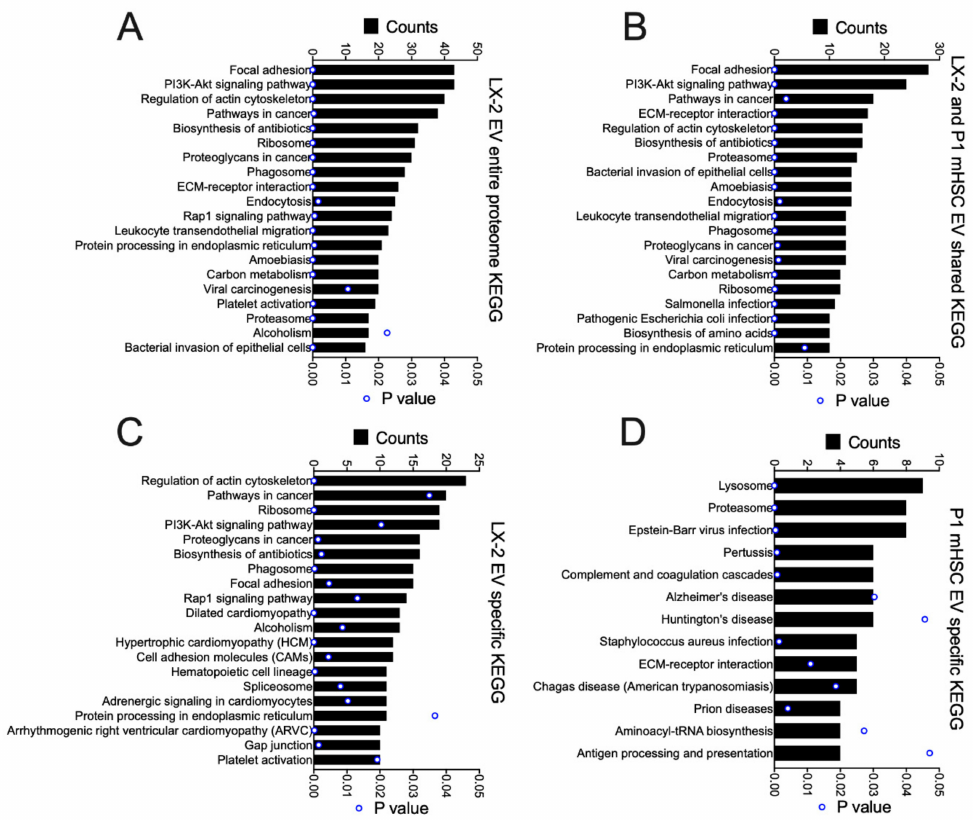
Figure 9. KEGG pathway analysis of proteins in EVs from LX-2 hHSC and / or P1 mHSC. EV proteins were analyzed as in Figure 6. The figure shows the top 20 pathways identified for ( A ) the entire LX-2 hHSC EV proteome; ( B ) proteins shared between LX-2 hHSC EVs and P1 mHSC EVs; or ( C ) proteins unique to LX-2 hHSC EVs. ( D ) Pathways identified for EV proteins that were specific to P1 mHSC. Only pathways with significant enrichment ( p < 0.05) are